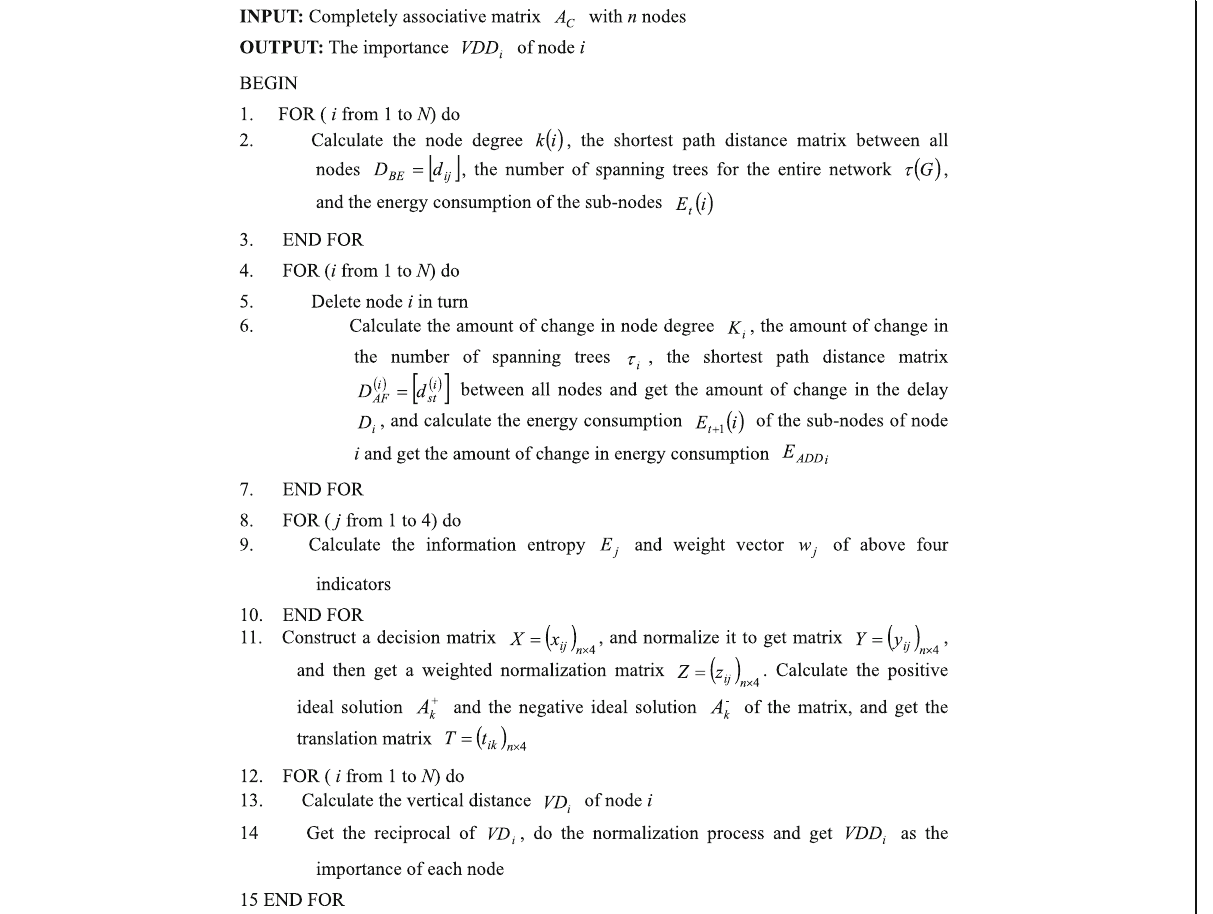
Fig. 2 The proceeding of the MADME method. The pseudo code of the MADME method that is an evaluation method for node importance based on a multi-attribute decision-making